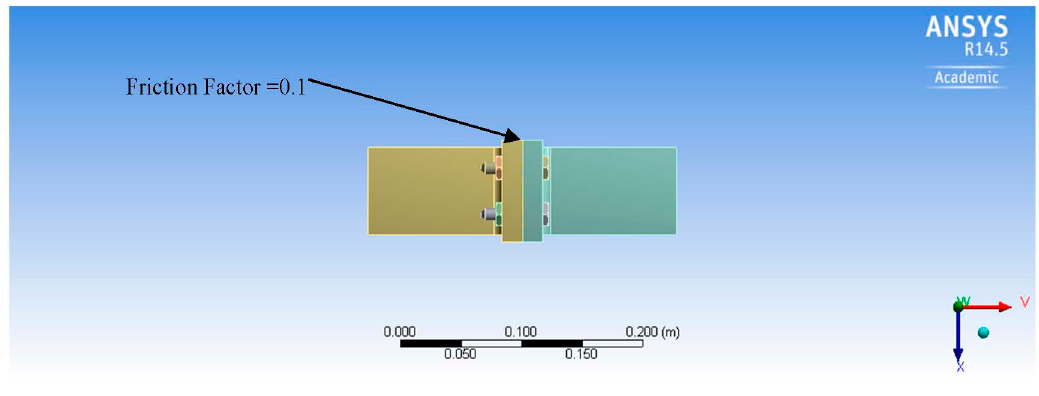
Figure 2. The friction factor at the area of contact between the two flanges that develops the non-linearity